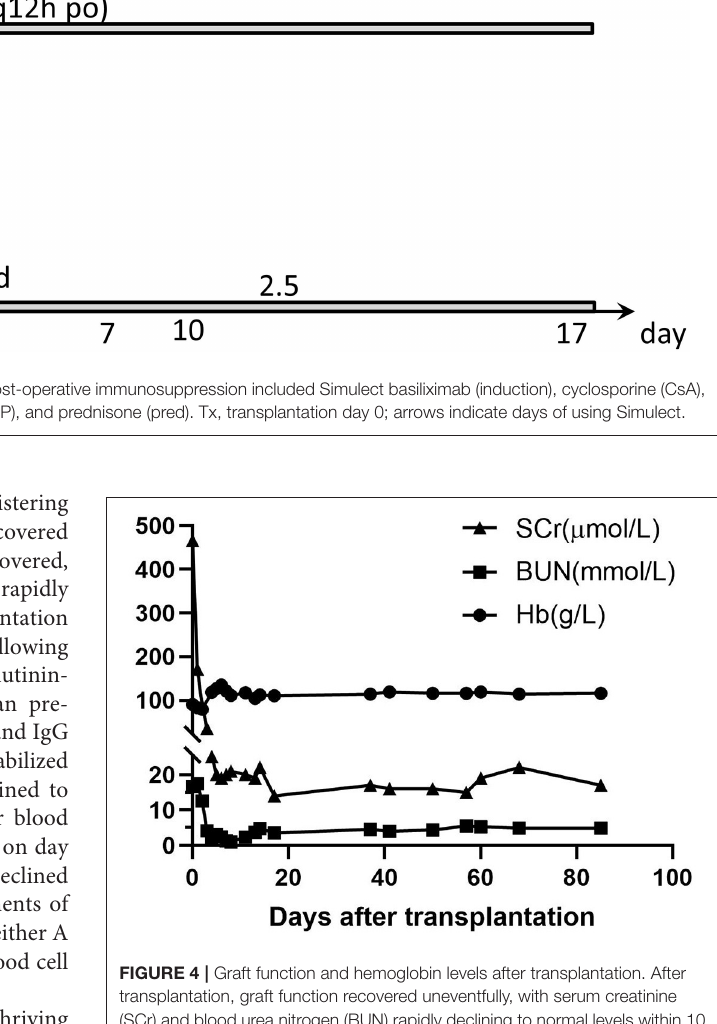
FIGURE 4 | Graft function and hemoglobin levels after transplantation. After transplantation, graft function recovered uneventfully, with serum creatinine (SCr) and blood urea nitrogen (BUN) rapidly declining to normal levels within 10 days post-transplantation. Recipient hemoglobin (Hb) recovered and stayed stable after